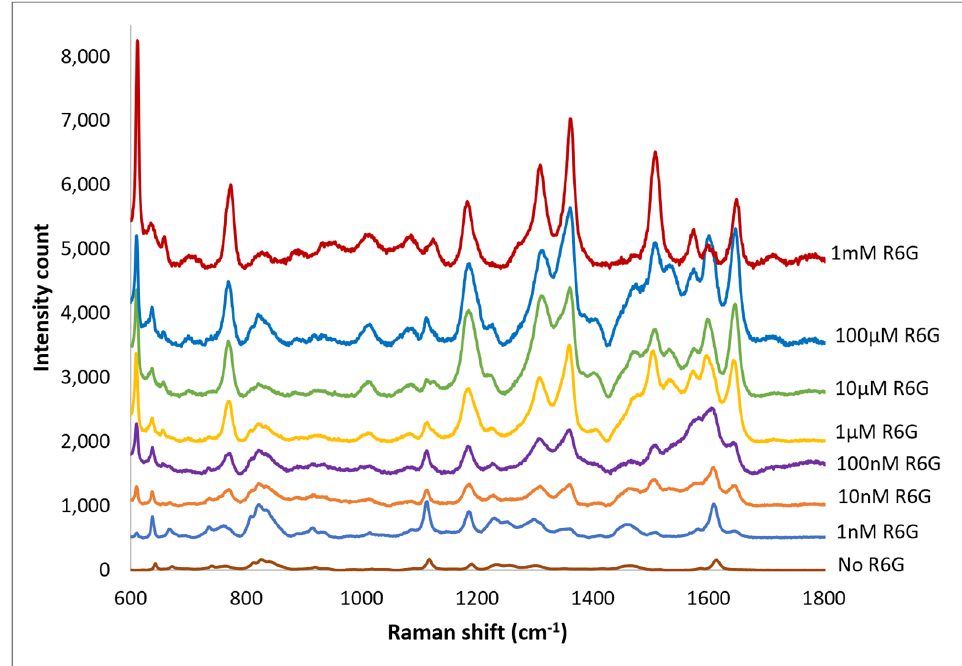
Figure 12. Top traces, Raman spectrum of 1 nm to 1 mm concentrations of R6G obtained after transferring silver nano-sphere suspension to epoxy on glass. Bottom trace, no R6G. For clarity, the spectra have been offset vertically.